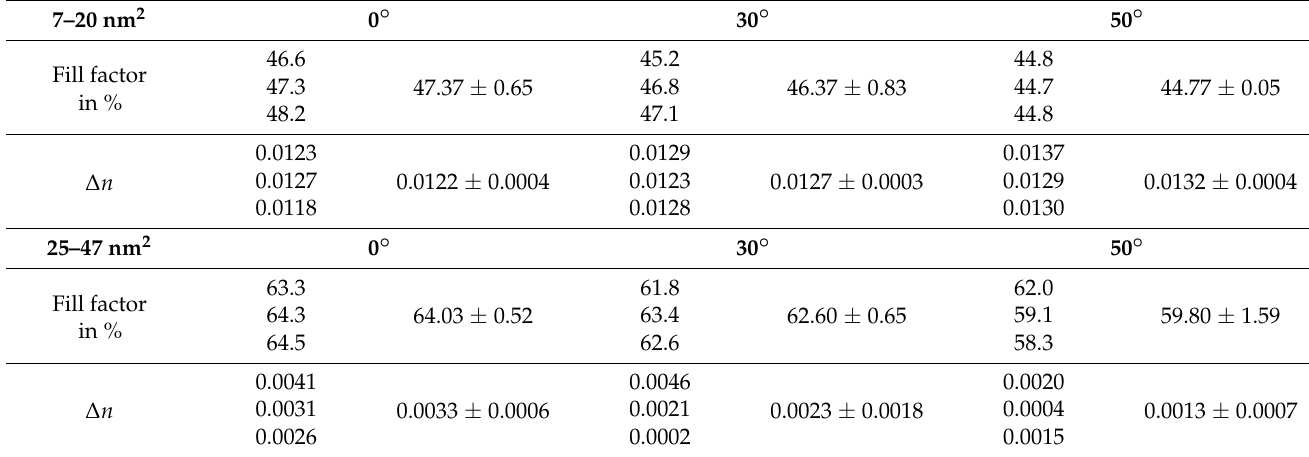
Figure 11. Standard deviation σ of the height during growth of the first layer (zig zag) and the continued growth of the second layer with different coating conditions on the right including also the fluctuation (standard deviation) as shaded region.